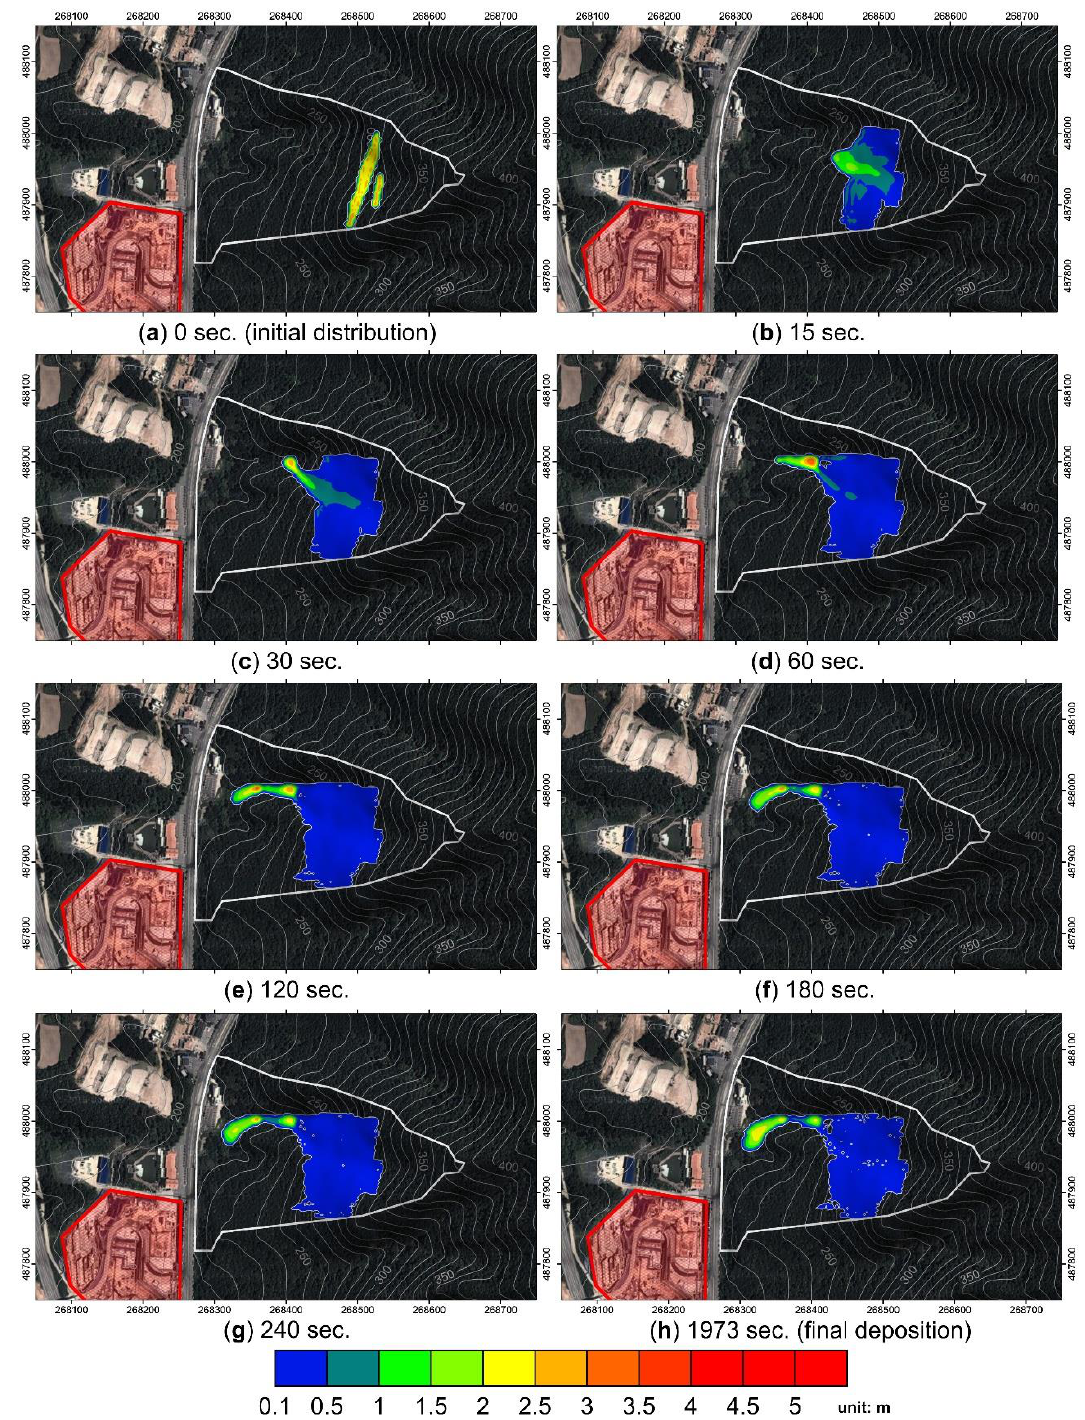
Figure 12. Simulated flow and thickness of debris at different times (( a )~( h )) in Watershed B.